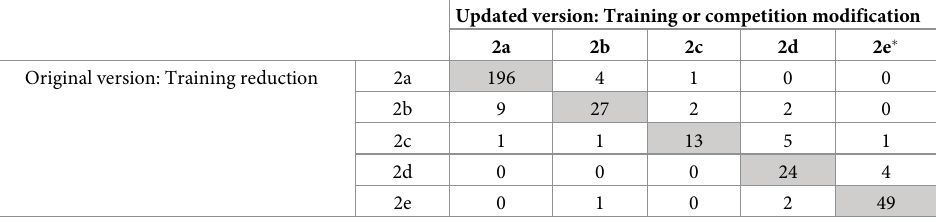
Table 2. Distribution between the responses to the original and updated versions of question 2 in Japanese